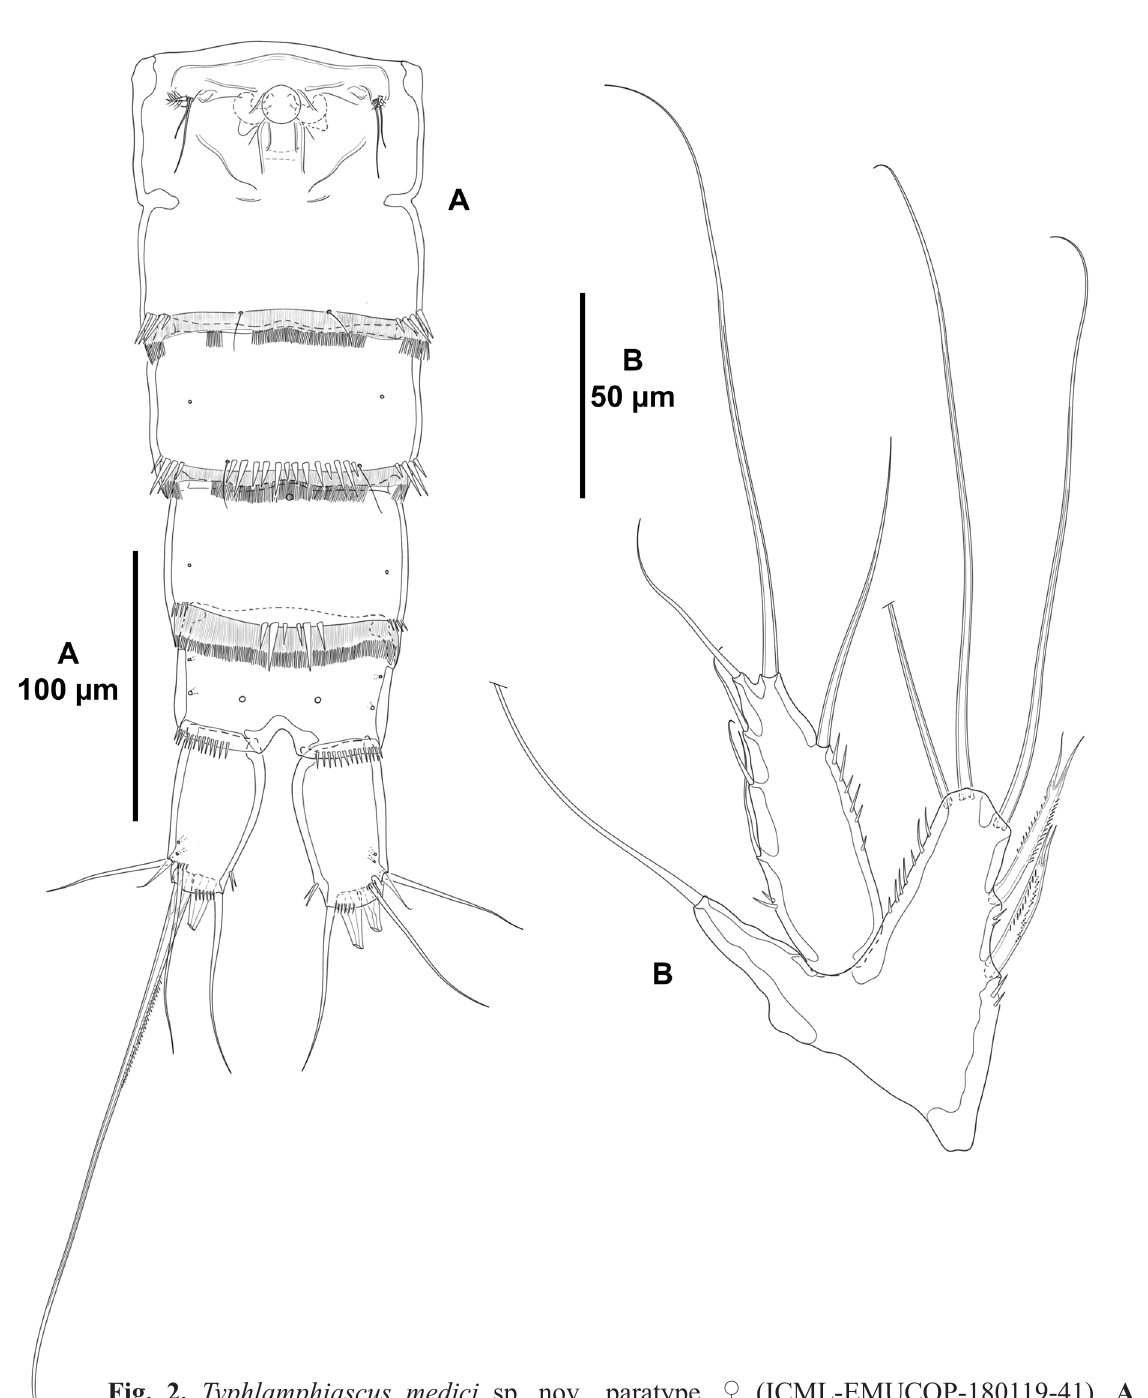
Fig. 2. Typhlamphiascus medici sp. nov., paratype, ♀ (ICML-EMUCOP-180119-41). A . Urosome, ventral view (P5-bearing somite omitted). B . P5, anterior